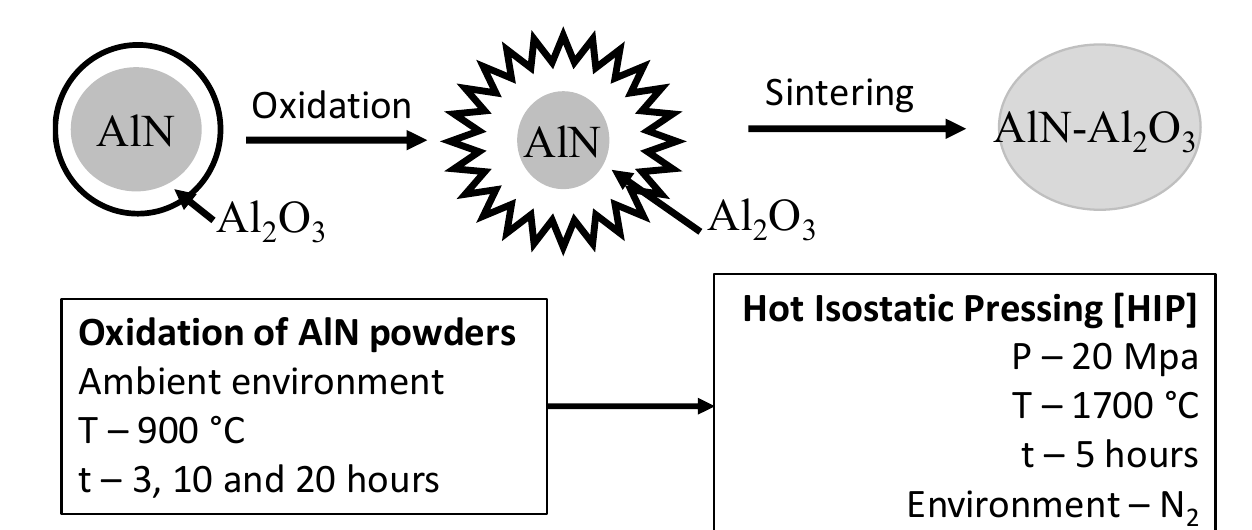
Figure 1. The percentage of conversion between AlN and Al 2 O 3 compounds depended on the time of oxidation as presented in Figure 2.